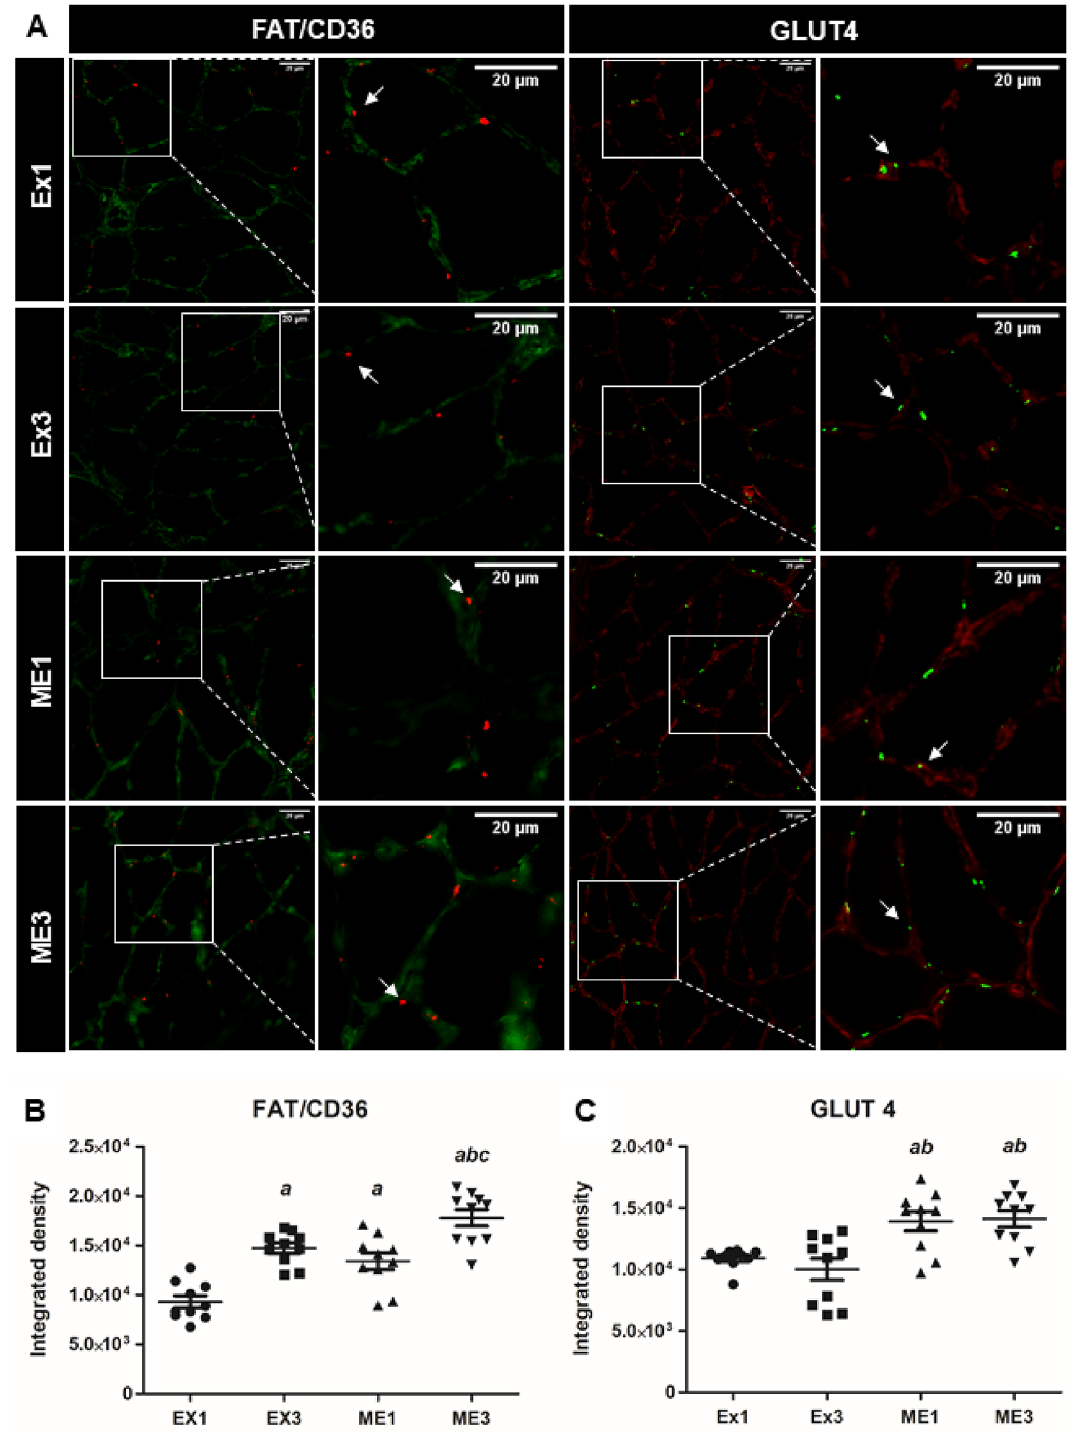
Figure 3. GLUT4 and FAT/CD36 in the skeletal muscle. Representative samples of laminin (green) with FAT/ CD36 (red) in the soleus skeletal muscle with immunofluorescence ( A ). Representative samples of laminin (red) with GLUT4 (green) in the soleus skeletal muscle with immunofluorescence ( A ) in rats that exercised and were euthanized 1 h (Ex1) or 3 h after t lim (Ex3) and rats that were treated with melatonin, exercised, and were euthanized 1 h (ME1) or 3 h after t lim (ME3). The white arrows indicate FAT/CD36 and GLUT4 in the soleus skeletal muscle. The figures show the means and standard errors of FAT/CD36 ( B ) and of GLUT4 (C). a p < 0.05 with respect to Ex1; b p < 0.05 with respect to Ex3; c p < 0.05 with respect to ME1 for the same parameter. For the illustration, objective lens = 20 × was used; bars = 20 µm; zoom = 300 height and 300